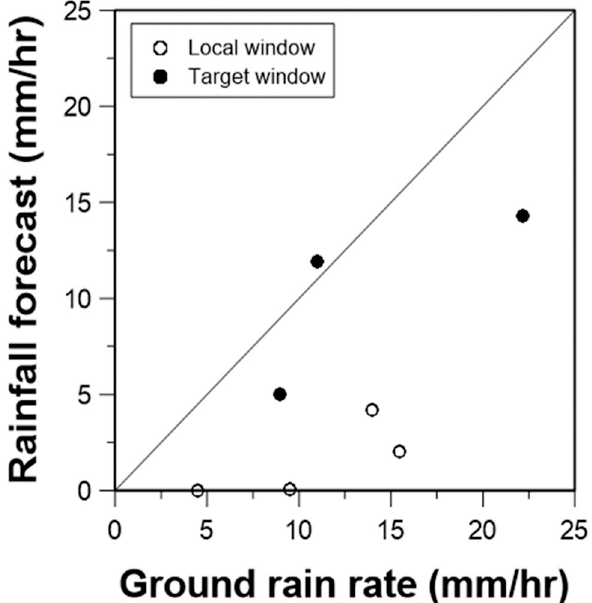
Figure 6. Comparison results of ground data and rainfall forecast at the local and target windows for the Ducsanggi Valley as an example (16:00 4 July).